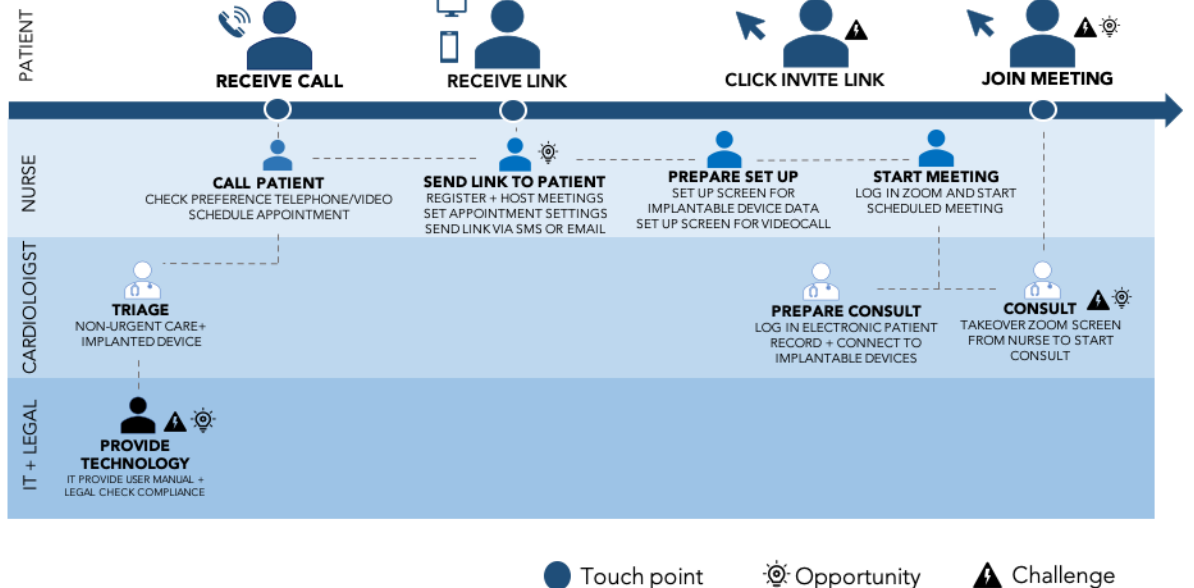
Video Consultation Technology: Need for